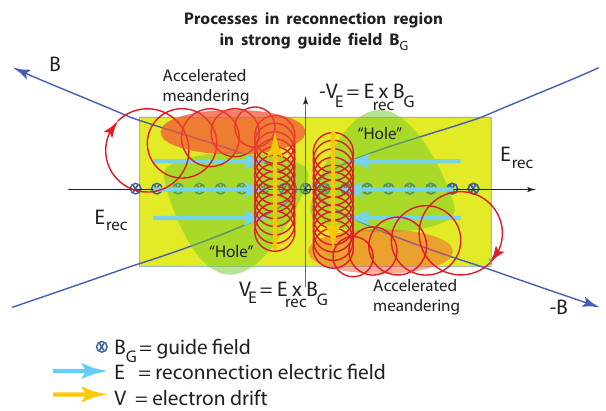
Figure 4. Schematic of the electron dynamics inside the electron ex- haust (rectangular yellow region) in the presence of a strong guide field (black crossed circles) directed into the plane and antiparallel to the current. The exhaust is shown as a rectangular region with re- connected magnetic field lines B . The blue arrows represent the re- connection electric field which points into the centre of the X point. Without guide field this field would expel and accelerate electrons out of the reconnection site, as is known from the non-guide field simulations. With strong guide field, however, it first forces the elec- trons to perform a E × B g drift upward to the left and downward to the right until the electrons accumulate at the exhaust boundary where the field ceases to exist and they are reflected from the cur- rent magnetic field B . This forms the green electron quasi-“holes” and the dense red regions of accumulated electrons. Reflection at the exhaust boundary forces the electrons to perform meandering motions along the guide field/current direction. During each such half-gyration they on their turning points experience the reconnec- tion electric field and like in a synchrotron become accelerated in the direction opposite to the electric field. This causes a stepwise increasing gyroradius shown here in the projection onto the plane perpendicular to the guide field. In effect these electrons ultimately reach high energy in the direction of the exhaust perpendicular to B g causing deformation of the momentum space distribution. This is the condition required for the ECMI to become